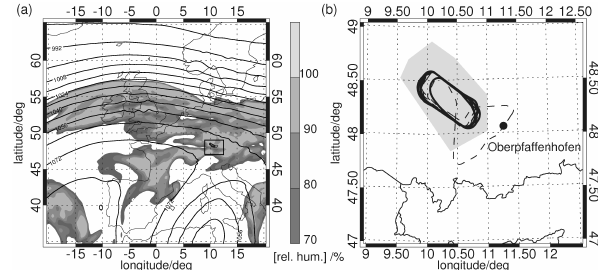
Figure 2. (a) ECMWF analysis of geopotential height (in dm, black contour lines) and relative humidity (%, grey shading) at 250hPa valid on 12:00UTC 4 November 2010. (b) Flight track of HALO between 10:46 and 13:32UTC (dashed line). The thick black line in (b) indicated the section shown in Fig. 3. Grey area in (b) shows the TRA Allgäu. Black rectangle in (a) indicates the section shown in (b)